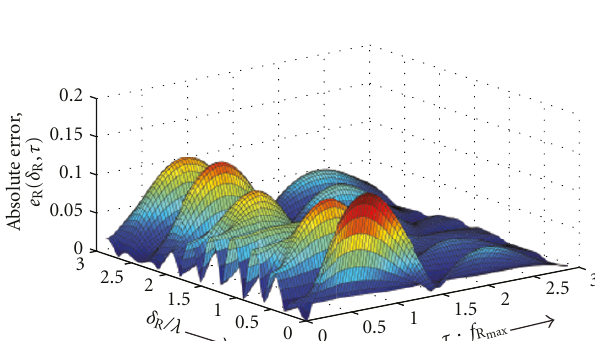
Figure 14: Absolute error e R ( δ R , τ ) = | ρ R ( δ R , τ ) − (cid:22) ρ R ( δ R , τ ) | by using the MMEA with K = L = 23 (nonisotropic scattering, von Mises density with φ (0)